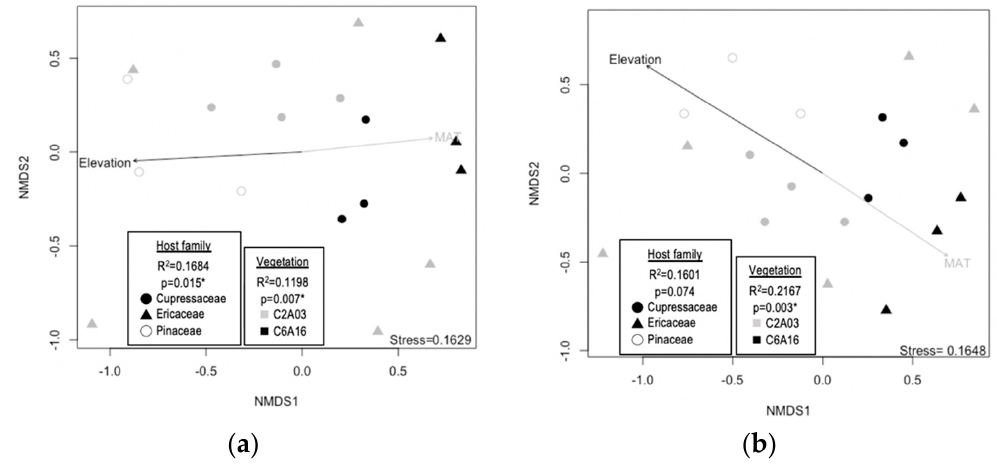
Figure 3. NMDS visualization of community structure using the Taipingshan data set. ( a ) Jaccard and ( b ) Morisita–Horn index of dissimilarity was calculated for the analyses, respectively. Each spot represents the endophyte community structure in a sample tree. The colors represent the vegetation types coded in Li et al. [21] (C2A03: Chamaecyparis montane mixed cloud forest; C6A16: Zelkova–Quercus rock-outcrop forest). Asterisks indicate the significance of PERMANOVA tests. Arrows indicate the significant relationships of elevation (Jaccard index: R 2 = 0.5914, p = 0.004; Morisita–Horn index: R 2 = 0.6384, p = 0.002), mean annual temperature (MAT; Jaccard index: R 2 = 0.6255, p = 0.001;